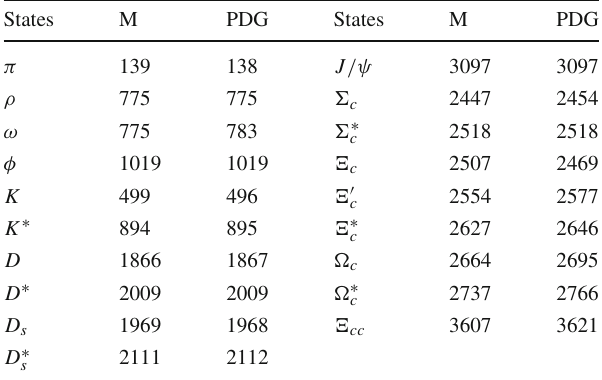
Table 6 Ground state hadron spectrum. The columns denoted by “M” are model calculations while the columns denoted by “PDG” are exper- imental data for the masses of these states in PDG [1]. The units are in